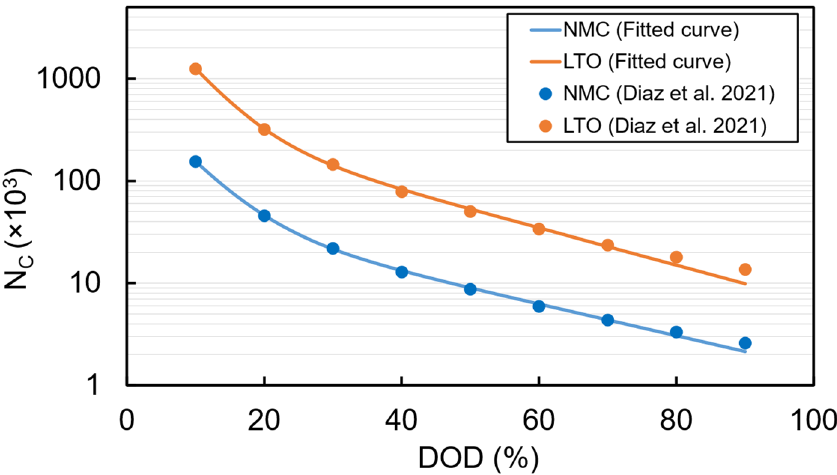
Figure 4. Number of cycles versus DOD [29].